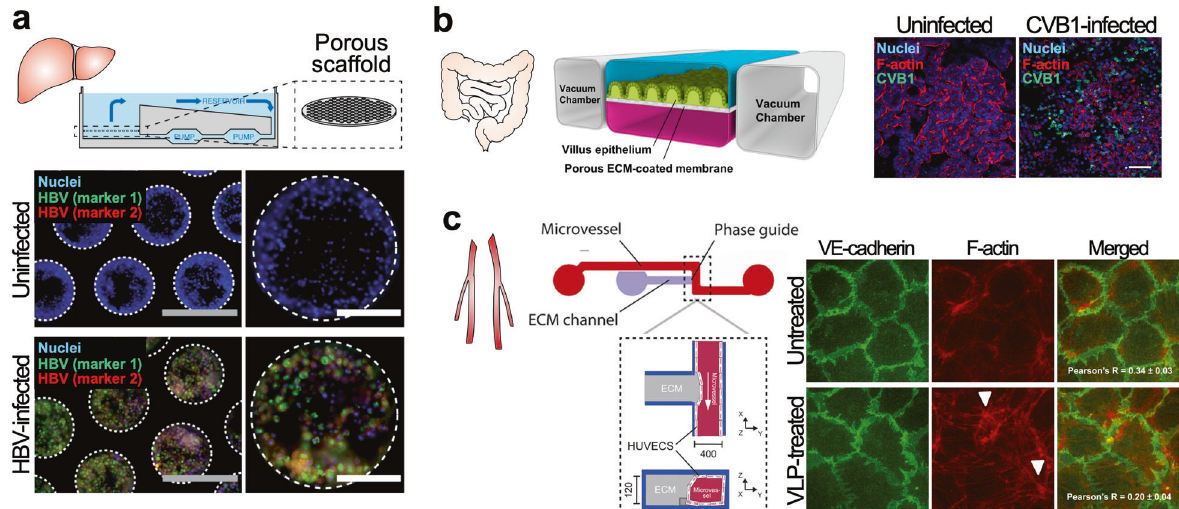
Fig. 4 Micro fl uidic-based human organs-on-chips applied in the study of infectious diseases. a Liver-on-a-chip for the study of hepatitis B virus (HBV) infection. Adapted from Ortega-Prieto et al. 113 b Gut-on-a-chip for the study of Coxsackie B1 Virus (CVB1) infection. Adapted from Villenave et al. 115 c Vascular endothelium barrier-on-a-chip for evaluating the effect of Ebola virus-like particle (VLP) on vascular integrity. White arrows indicate remodeling of F-actin. Adapted from Junaid et al. 116